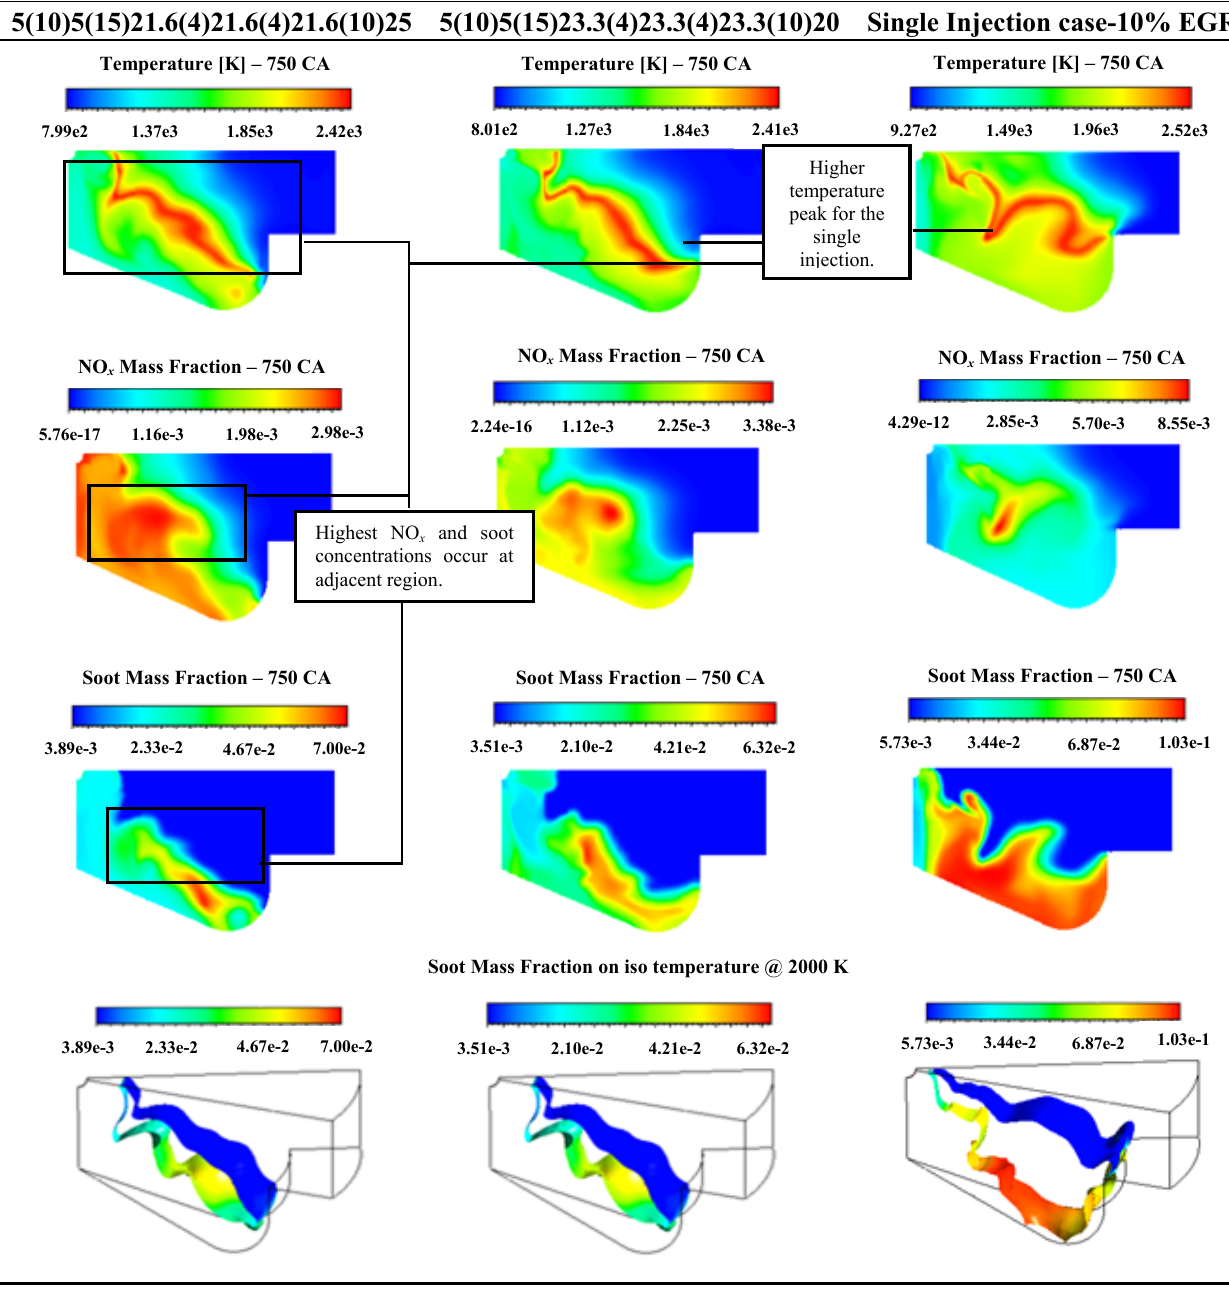
and soot contour plots at ( a ) 750 CA and ( b ) 765 CA. x ( a ) 750 CA